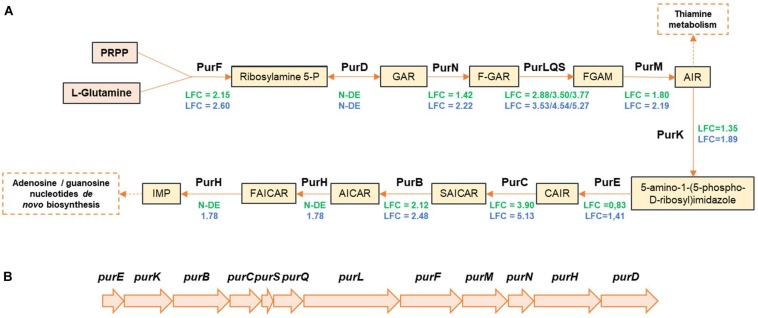
Proposed pathway of purine biosynthesis in meat juice by B. thermosphacta strains CD 337 and TAP 175 (A), and pur operon organization (B). LFC values were represented with a color code depending on strain: CD 337 (green); TAP 175 (blue). Abbreviations: N-DE, not differentially expressed; PRPP, 5-phosphoribosylpyrophosphate; GAR, glycinamide ribonucleotide; FGAR, formylglycinamide ribonucleotide; FGAM, formylglycinamidine ribonucleotide; AIR, aminoimidazole ribonucleotide; CAIR, carboxyaminoimidazole ribonucleotide; SAICAR, N-succinocarboxamide-5-aminoimidazole ribonucleotide; AICAR, aminoimidazole-4-carboxamide ribonucleotide; FAICAR, 5-formamido-4-imidazolecarboxamide ribonucleotide; IMP, inosine monophosphate.